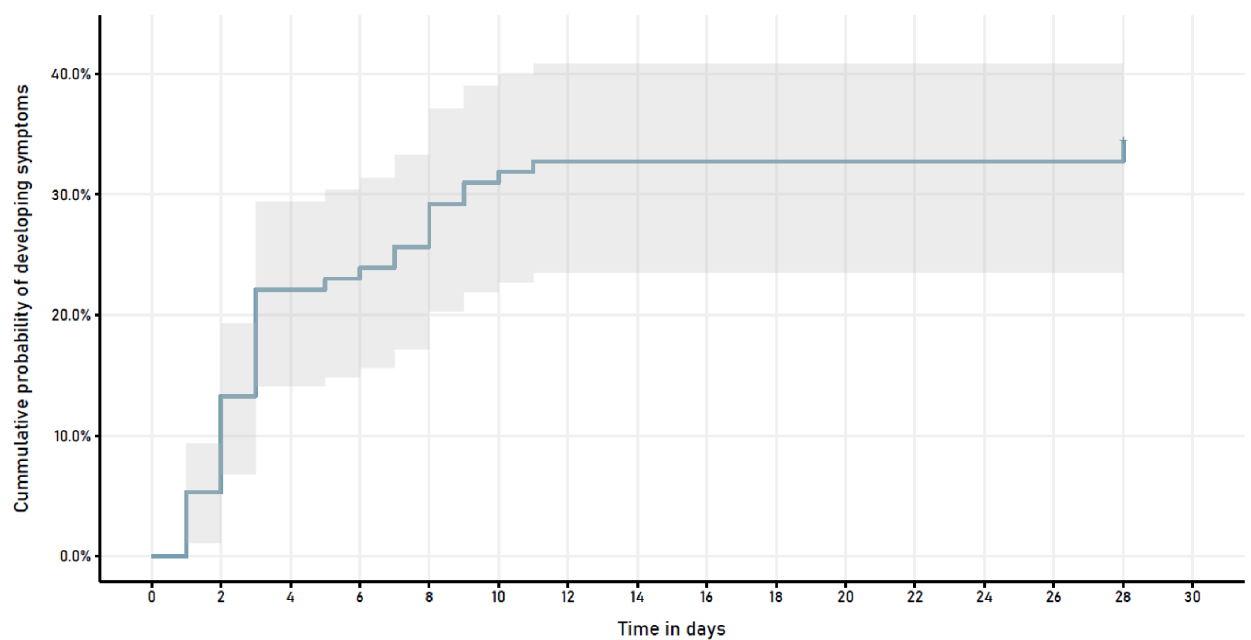
Figure 1. Symptom development in patients who were asymptomatic at time of COVID-19 diagnosis.